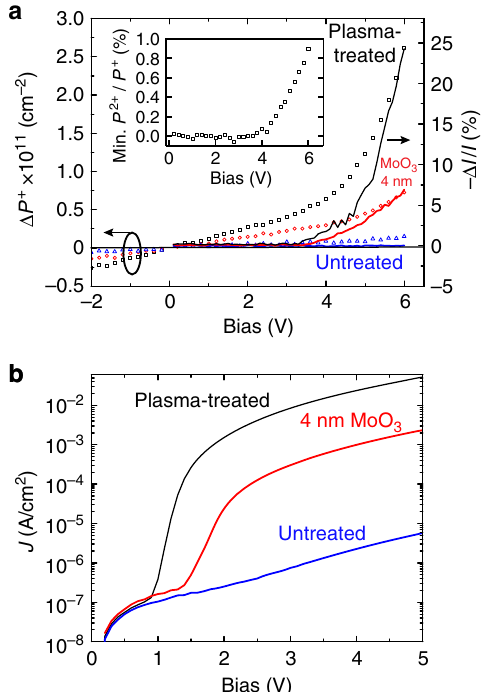
Fig. 3 Impact of anode surface treatment. a Bias-dependent change in interfacial polaron concentration, Δ P + , calculated for a series of devices with different ITO surface treatments based on their associated charge modulation spectra. The polaron concentration is maximum for plasma- treated ITO (black squares) and becomes much smaller without the plasma treatment (blue triangles). Adding a 4 nm thick MoO 3 layer leads to an intermediate polaron concentration (red circles). The right-hand axis shows that the magnetocurrent response of each device trends with the overall change in polaron concentration between them; however, the magnetocurrent exhibits a stronger voltage dependence than the polaron density within any given device. The inset shows the minimum absolute bipolaron-to-polaron ratio ( P 2+ / P + ) estimated for the plasma-treated ITO device as a function of bias; the bipolaron CM signal for the other devices was below the detection limit. b Current – voltage relationship measured for each device